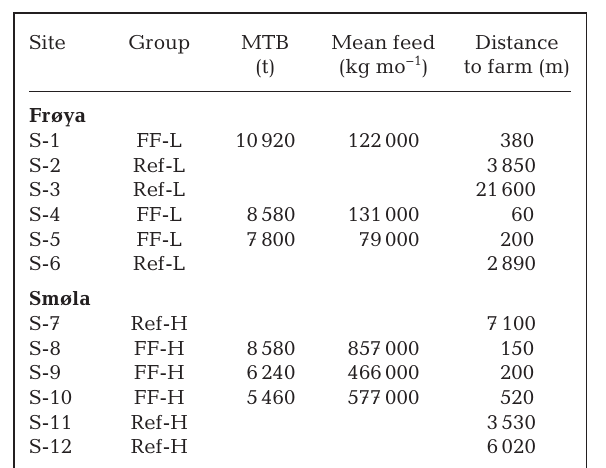
Table 1. Overview of sampling sites for Laminaria hyper- borea kelp plants collected from salmonid fish farming (FF) sites (low effluent load: FF-L, high effluent load: FF-H) and reference sites (Ref-L, Ref-H) in the Frøya (Ref-L, FF-L) and Smøla (Ref-H, FF-H) archipelagos, Norway, August 2015. Information is also given on the maximum total fish biomass (MTB) permitted at the farm, the mean amount of feed-use at farms for the 6 mo prior to sampling (January−July 2015), and the distance to the nearest